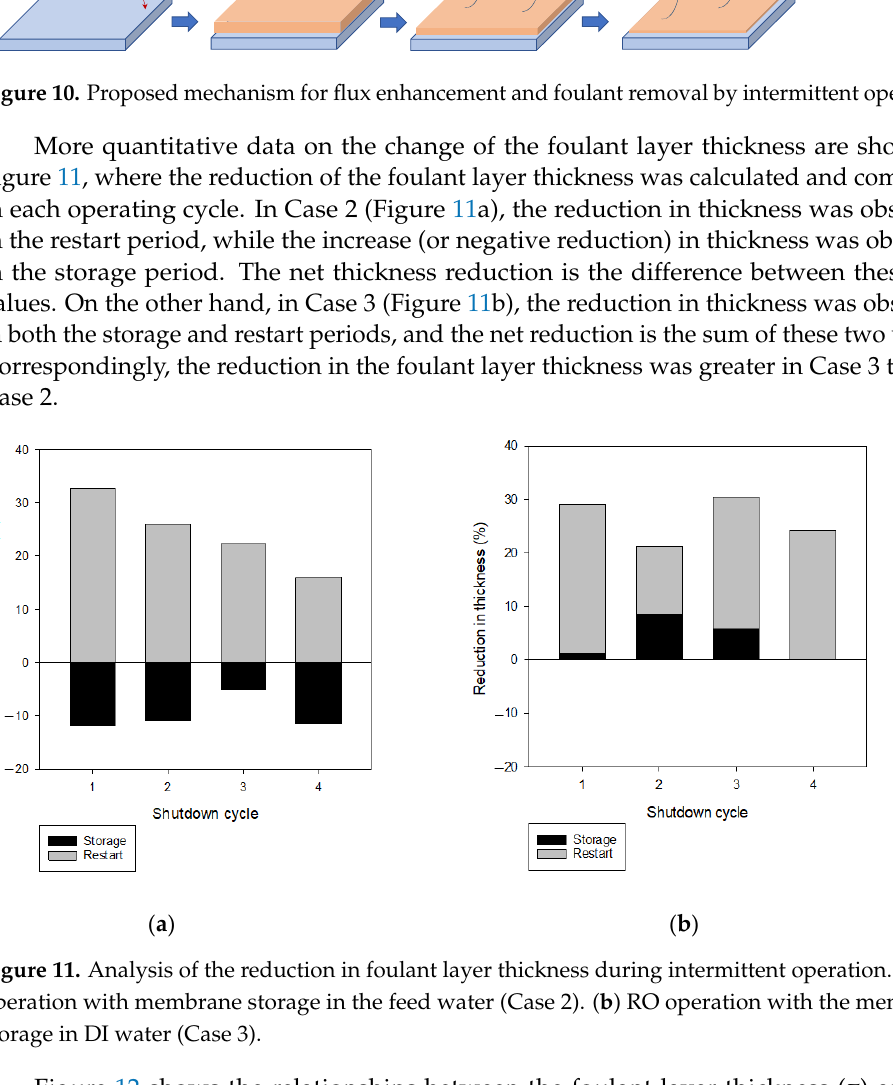
Figure 10. Proposed mechanism for flux enhancement and foulant removal by intermittent operation.